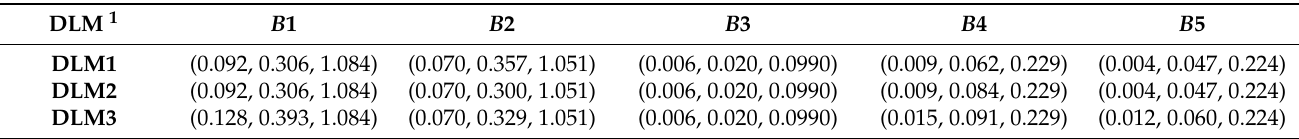
Table 8. Weighted normalized fuzzy decision matrix for three distance learning course information tools usage assessment by five criteria. DLM